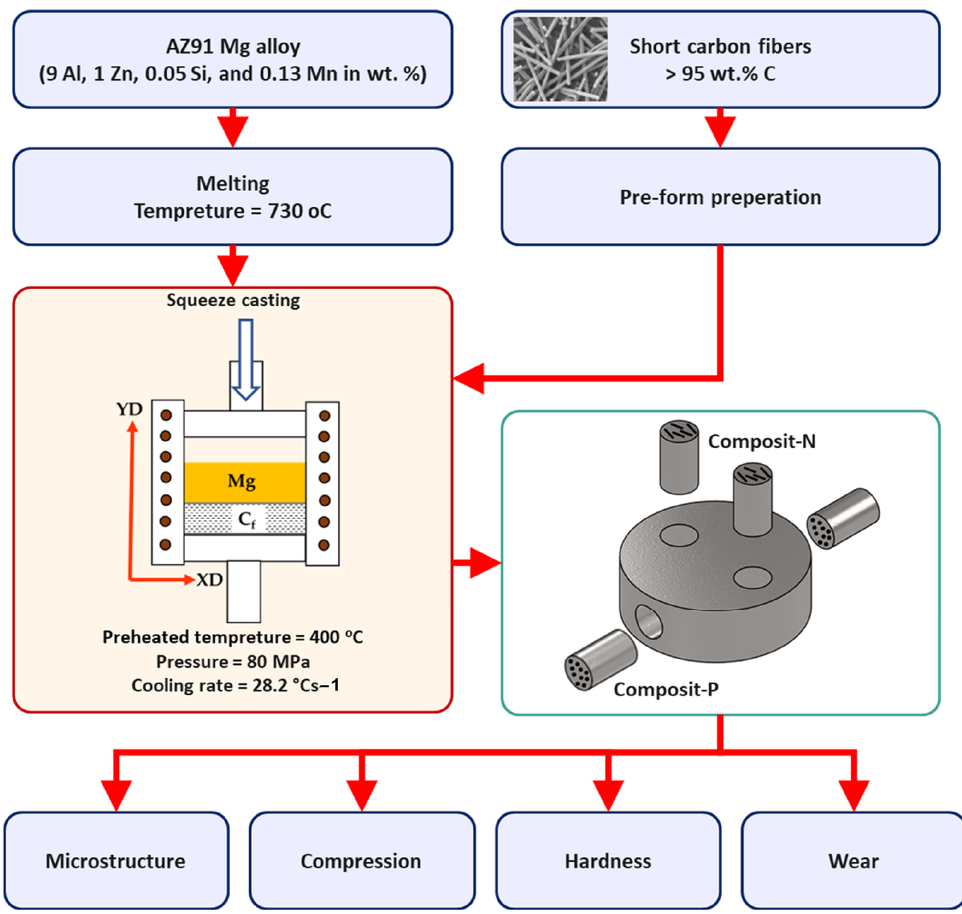
Figure 1. The flow chart summarizes the experimental procedure to produce and characterize the AZ91-BM and its composites.